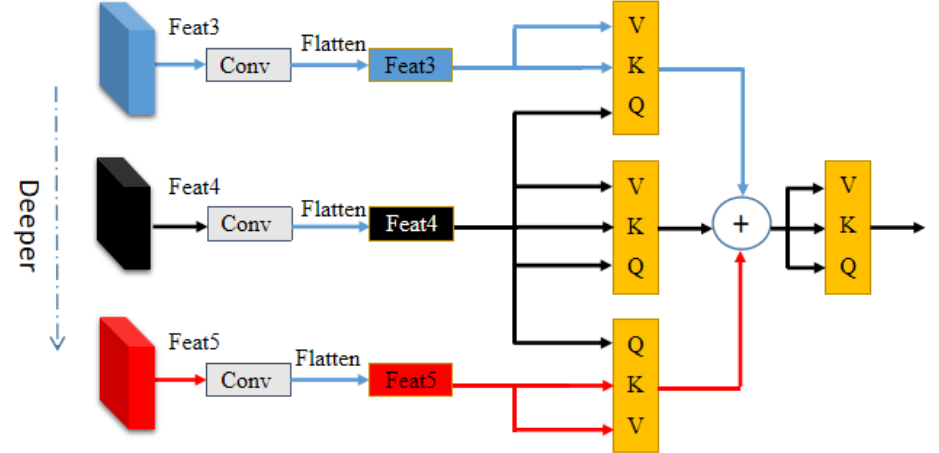
Figure 3. Transformer Feature Pyramid.Features form Feat3-Feat5 are flattened and fed into TFE blocks. TFN consists of 4 TFE blocks.Hierarchical information are extracted by 3 separate TFE blocks, and further enhanced by 1 additional TFE block.